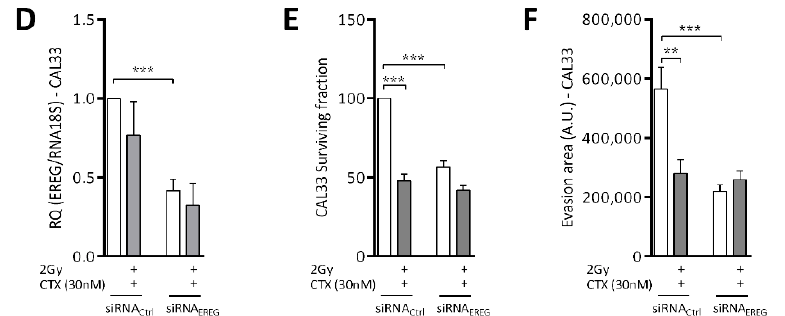
Figure 4. Overexpression of Cav1 is associated with a decrease in EREG-driven oncogenic addiction. ( A ) Quantitative determination of AREG, EREG and MYC transcripts in CAL33 Ctrl and CAL33 Cav1 cells exposed to 2 Gy irradiation, 30 nM cetuximab or a combination of both using RT-qPCR with RNA18S as a control. Each bar represents the mean ( n = 3–5) ± SEM (* p < 0.05, ** p < 0.01). ( B ) Expression of EGFR and GAPDH was determined by Western blot (WB) in CAL33 Ctrl and CAL33 Cav1 cells exposed to 2 Gy irradiation, 30 nM cetuximab and a combination of both. Western blots are representative of 3–5 independent experiments. EGFR levels were analyzed using GAPDH as a loading control. Each bar represents the mean ( n = 3-5) ± SEM (* p < 0.05). ( C ) Immunofluorescence analysis of EGFR by confocal microscopy in CAL33 Ctrl and CAL33 Cav1 cells exposed to 2 Gy irradi- ation, 30 nM CTX, and a combination of both. Nuclei were stained using DAPI. Arrows show the region of the plasma membrane concentrating EGFR staining ( × 63). ( D ) Quantitative determination of EREG transcripts in CAL33 siRNA-Ctrl and CAL33 siRNA-EREG cells exposed to a combination of 2 Gy irradiation and 30 nM CTX using RT-qPCR with RNA18S as a control. Each bar represents the mean ( n = 3–5) ± SEM (*** p < 0.001). ( E ) Clonogenic survival of CAL33 siRNA-Ctrl and CAL33 siRNA-EREG cells was determined 10 days after exposure to a combination of 2 Gy irradiation and 30 nM CTX. Histograms represent the surviving fraction in each condition. Data are represented as the mean ( n = 3–5) ± SEM (*** p < 0.001). ( F ) Analysis of collective cell migration: evasion of CAL33 siRNA-Ctrl and CAL33 siRNA-EREG 24 h after treatment with a combination of 2 Gy irradiation and 30 nM CTX out of the spheroids. Pictures show the evasion area and histograms represent the mean ( n = 3–4) ± SEM (** p < 0.01 and *** p < 0.001) area covered by cells evading the